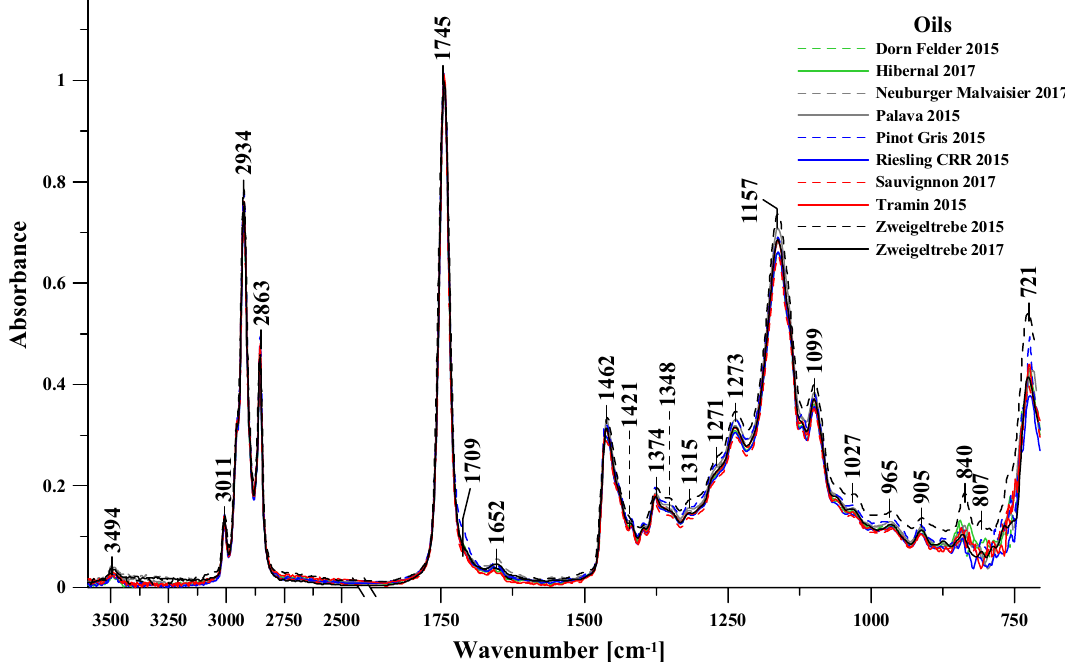
Figure 4. FT-IR spectra, normalised for the wavelength of 1745/cm, recorded for the respective grape seed oil samples: Dornfelder 2015 (dashed green), Hibernal 2017 (solid green), Neuburger 2017 (dashed gray), Pálava 2015 (solid gray), Pinot Gris 2015 (dashed blue), Riesling 2015 (solid blue), Sauvignon 2017 (dashed red), Tramin 2015 (solid red), Zweigeltrebe 2015 (dashed black) and Zweigeltrebe 2017 (solid black) respectively. All spectra are presented in the spectral range of 700–3600/cm and recorded at 23